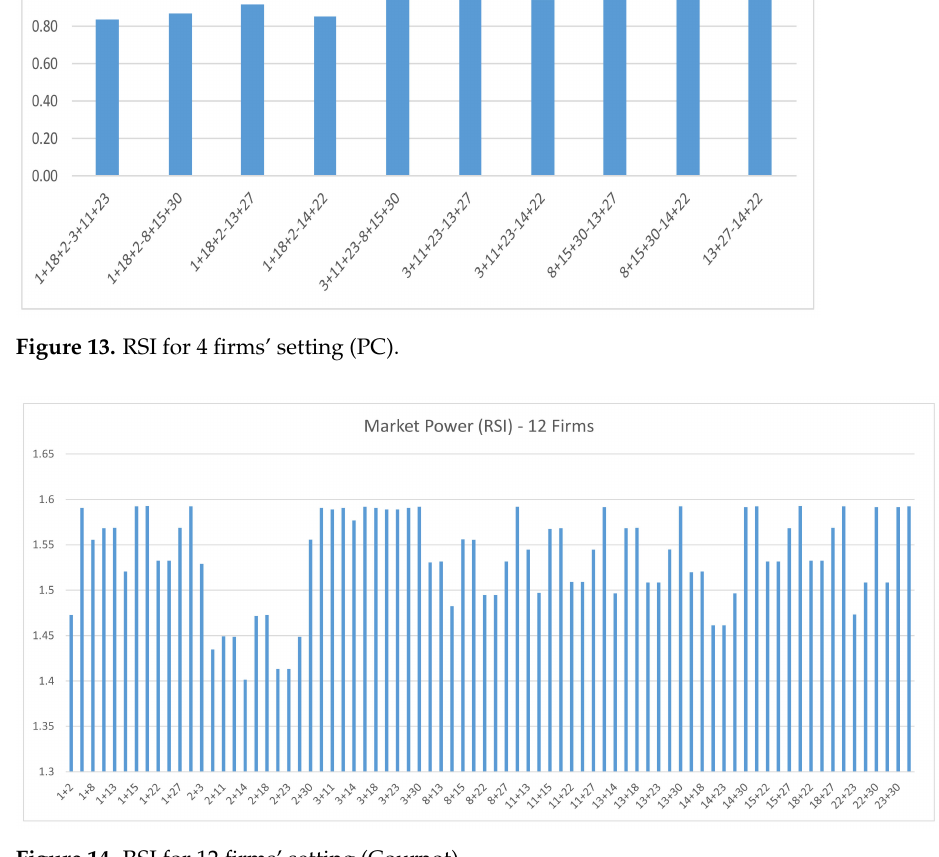
Figure 14. RSI for 12 firms’ setting (Cournot).